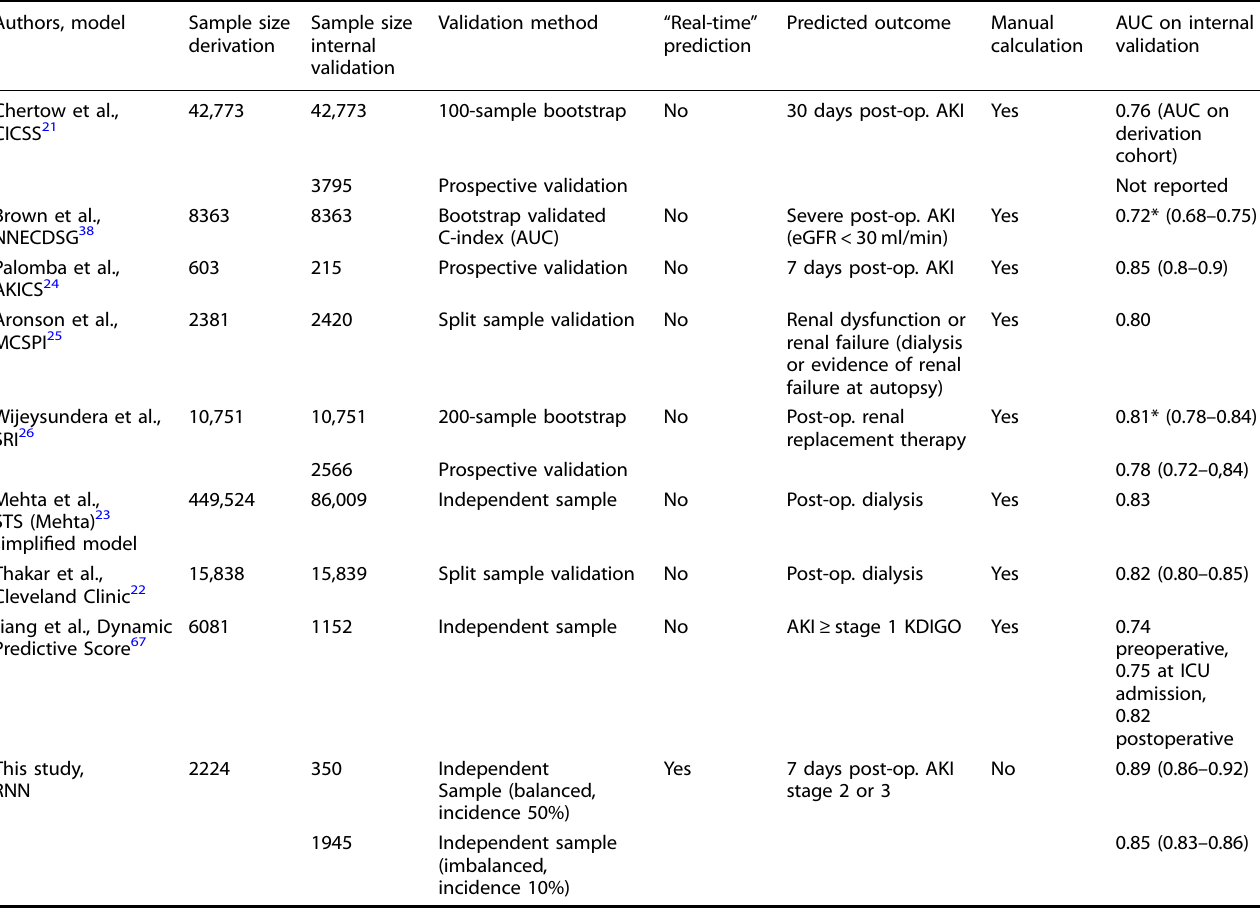
Table 4. Comparison between classical prediction models 20 based on logistic regression and our recurrent neural network (RNN). Authors,